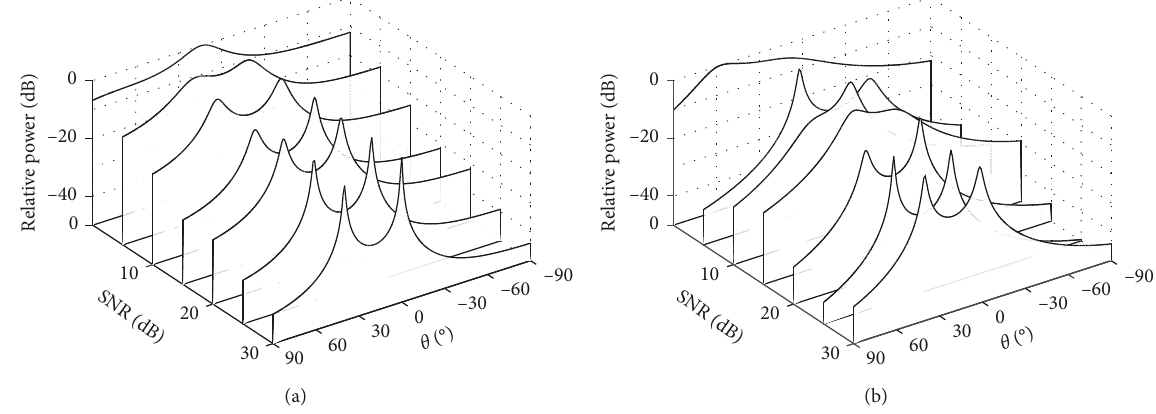
Figure 3: MUSIC spectrum of the dual CLM antenna array versus the SNR with incident angles of 0 ° and 40 ° . (a) Incoherent signals. (b) Coherent signals.